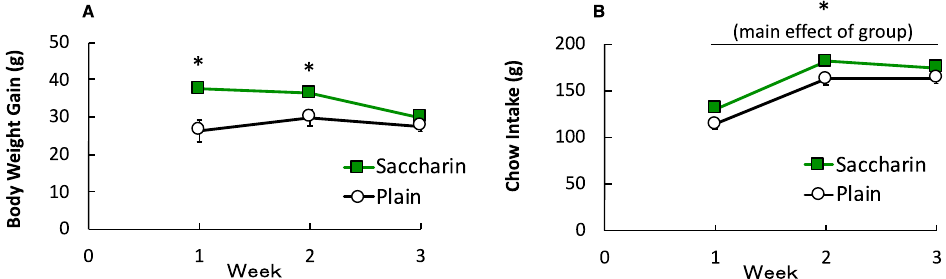
Figure 2. Mean body weight gain ( A ) and mean chow consumption ( B ) during the yogurt phase. Data points indicate means ± SEMs ( n = 7 for each group). The error bars were sometimes smaller than the height of the symbols. Asterisk indicates a significant difference between the groups.